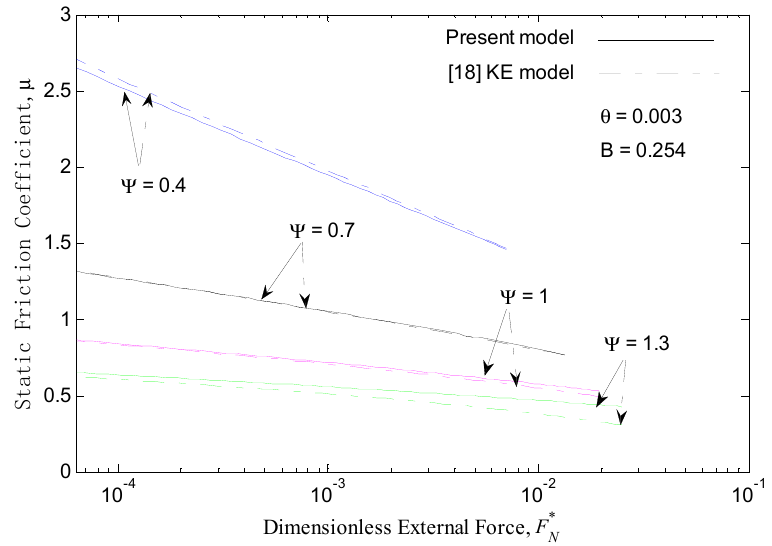
* F max s versus dimensionless external force 0.003 θ= Ψ at .